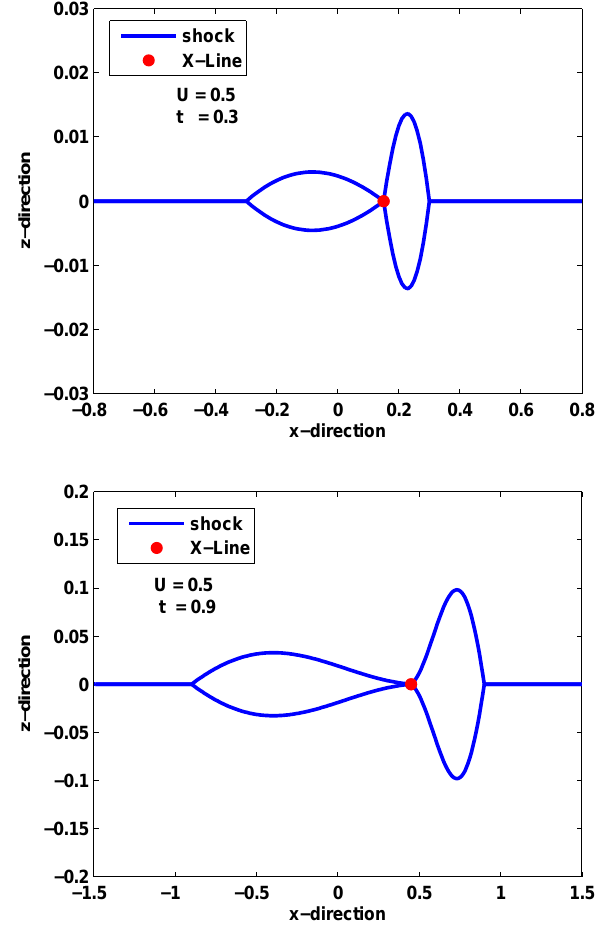
Fig. 4. Structure of the field reversal region during active reconnec- tion (switch-on phase) for the times t = 0 . 3 (upper panel) and t = 0 . 9 (lower panel) and velocity of the reconnection line U = 0 . 5 v A . Mind the different axis scaling in the upper and lower panel.